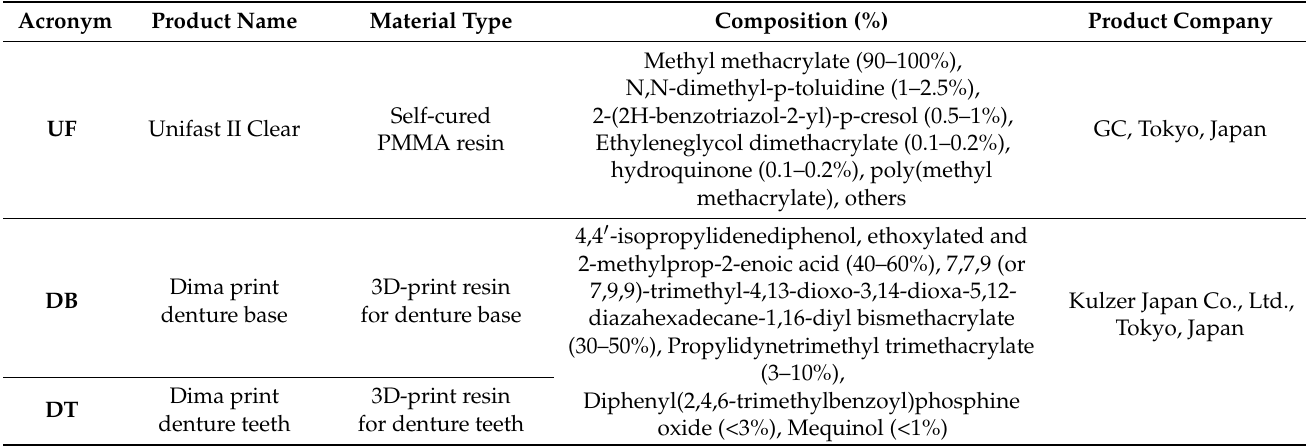
Table 2. Commercial products used for control